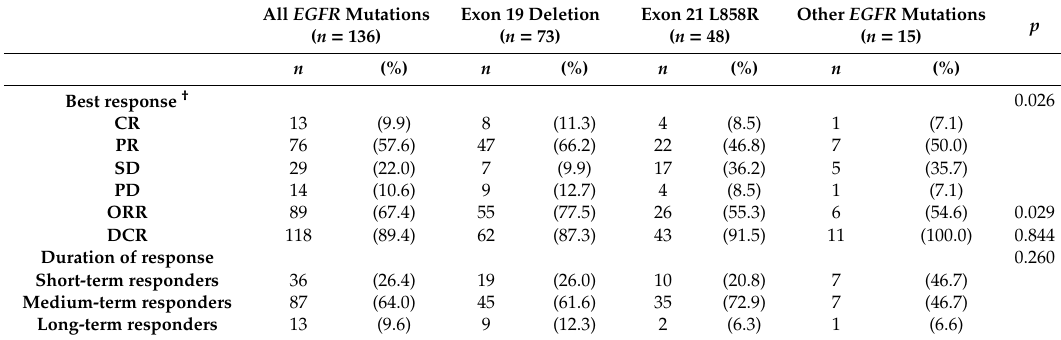
Table 2. Best clinical response according to EGFR